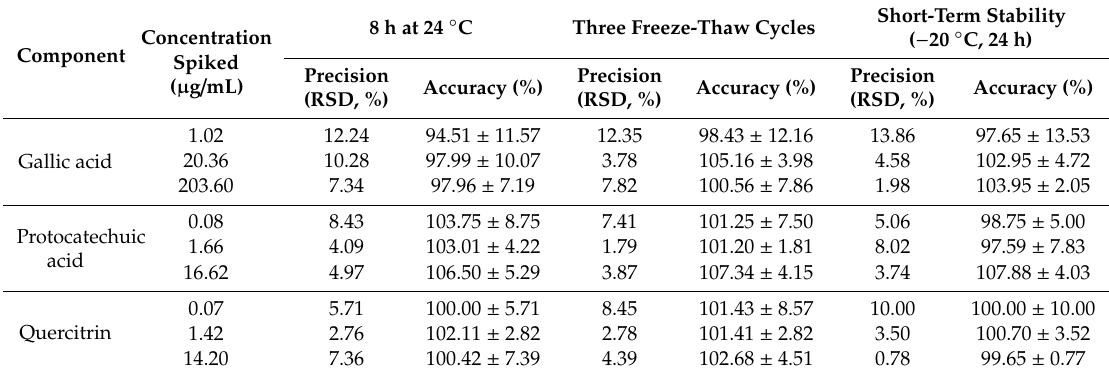
Table 3. Stability of the three components in rat plasma under various storage conditions (mean ± SD, n =